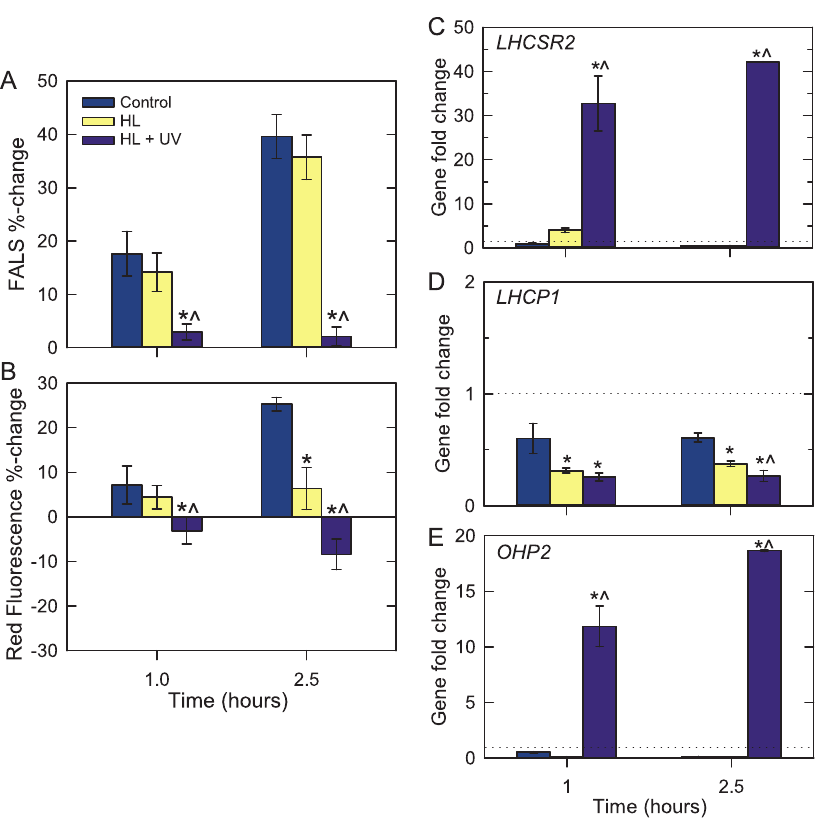
Fig 4. Cellular characteristics of M . commoda during short-exposure light shift experiments and qPCR analysis of three genes. Percent changein (A) mean normalizedFALS cell -1 and (B) mean bead normalized red fluorescence for controls and the HL and HL+UV treatments. Data represent the percent changerelative to T 0 , which occurred 4.5 h after lights-on, and the x-axis units are time from the experiment start (in hours). Cells were grown at 100 μ mol photonsm -2 s -1 for (cid:21) 9 generationsprior to manipulation. On the day of the experiment, cultures were sampledat T -4.5 , transferred to flasks and placed in their respective treatments at T 0 . Data represent the averageof four to twelve flasks as detailedin materials and methods, and error bars represent standarddeviationsof these flasks. (C-E) Fold-changes in gene expressionfor select genesby qPCR. Values > 1 increasedrelative to the T 0 control, while those < 1 decreased. Note differences in y-axis scales. Samples that were significantly different ( p < 0.01)from the control ( * ) and HL+UV samples that were significantly different from HL at the same time point (^) are denoted. Data represent the averageof four biologicalreplicatesand error bars represent the